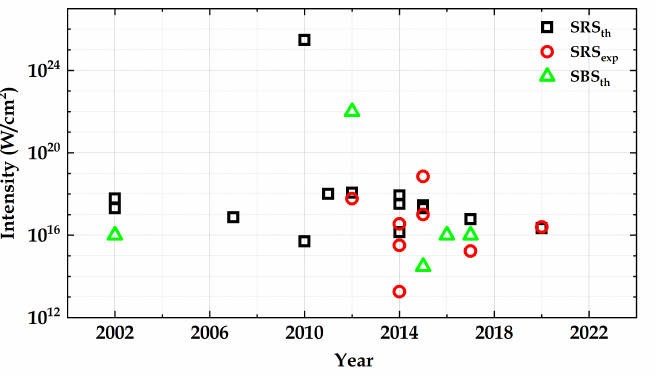
Figure 5. Intensity of the seed pulse predicted/obtained with time from 2000 to 2022 for Raman amplification and Brillouin amplification are presented